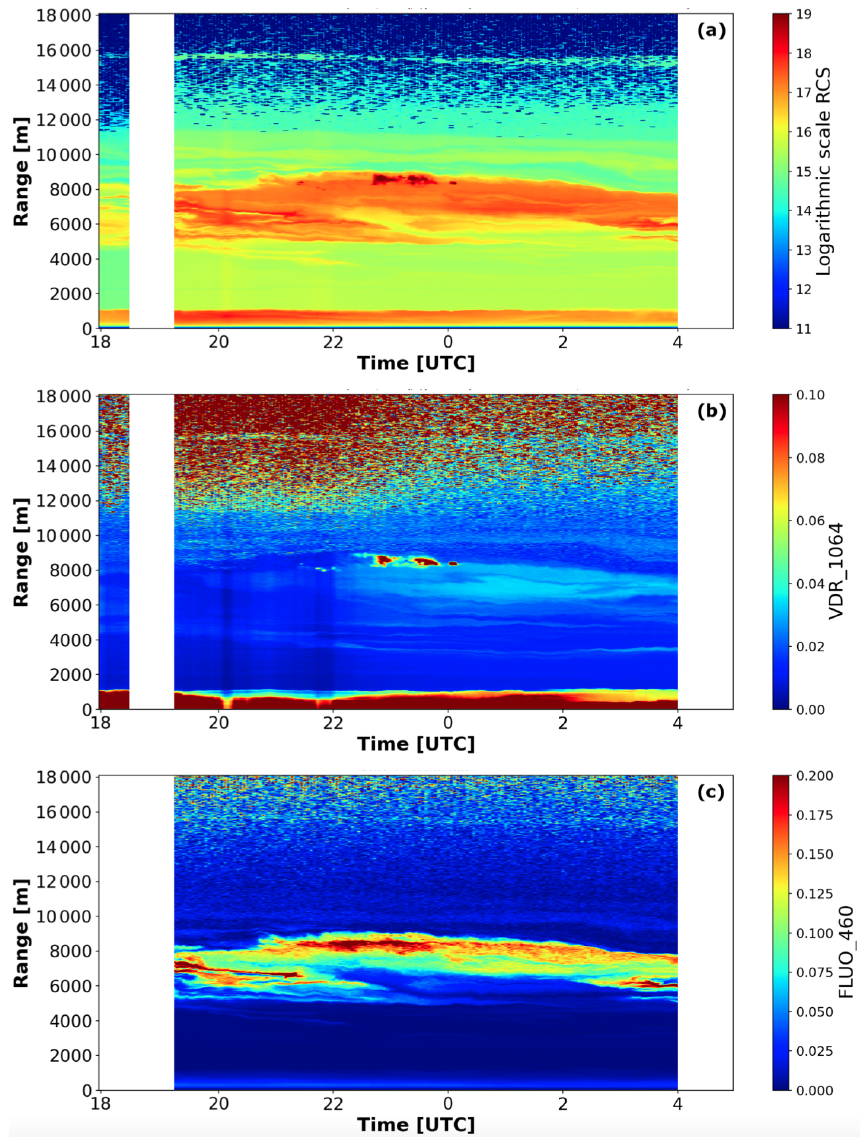
Figure 9. The same plot as Fig. 7 but for lidar observations from 17 to 18 September 2020. (a) Range corrected lidar signal at 1064nm, (b) volume depolarization ratio at 1064nm and (c) calibrated signal ratio between 466 and 387nm